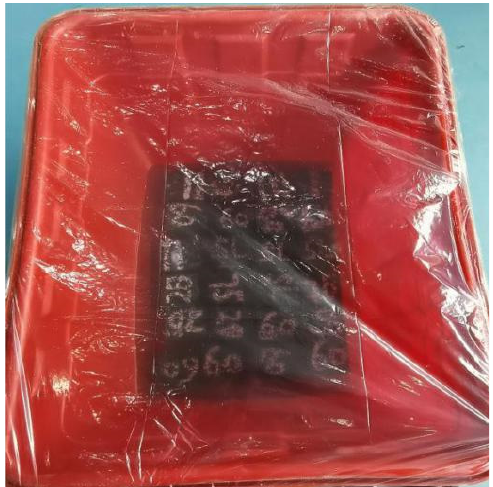
Figure 13. The acidic corrosion of the specimens.